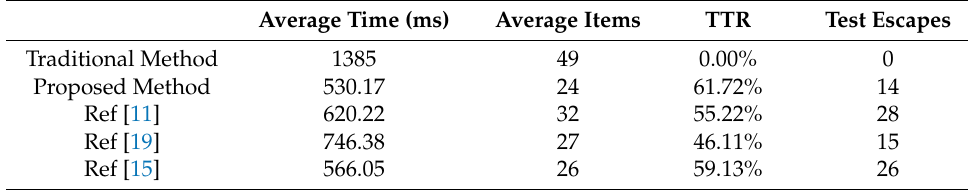
Table 2. Comparison with other methods.